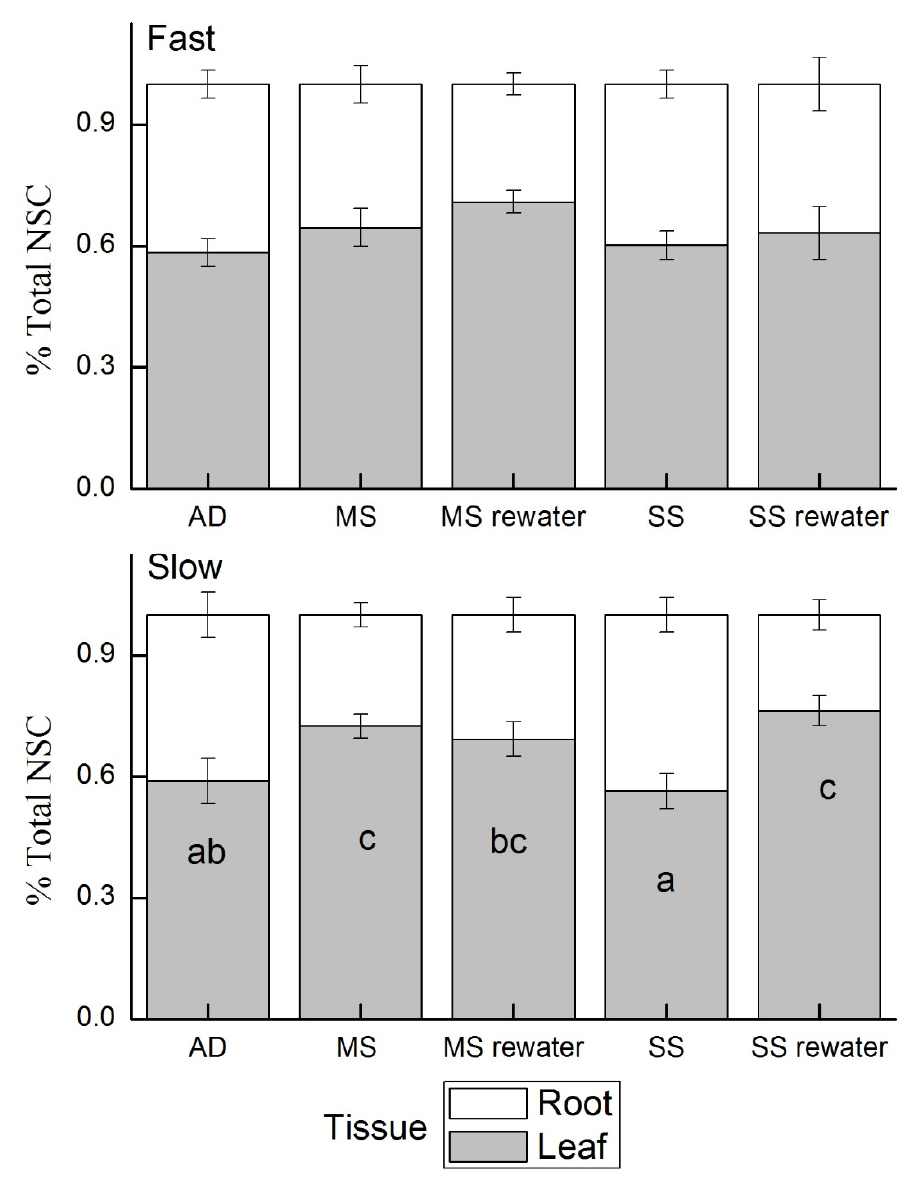
Figure 4. Partitioning of total NSC pool (soluble sugars + starch) across various tissues (leaf and root). Letters indicate significant differences ( p < 0.05) for treatments, including AD (control, absence of drought), MS (moderately water-stressed), SS (severely water-stressed), MS rewater (moderately water-stressed plants that were rewatered after drought) and SS rewater (severely water-stressed plants that were rewatered after drought). Error bars represent ± standard error.